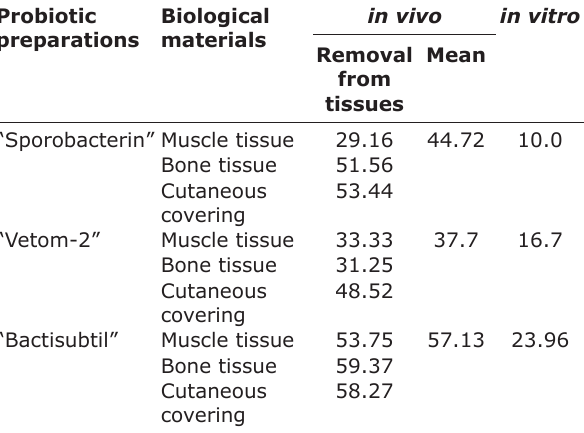
Table-3: Dynamics of copper removal with probiotic preparations in vivo (on the 21 st day of the experiment) and in vitro in %.